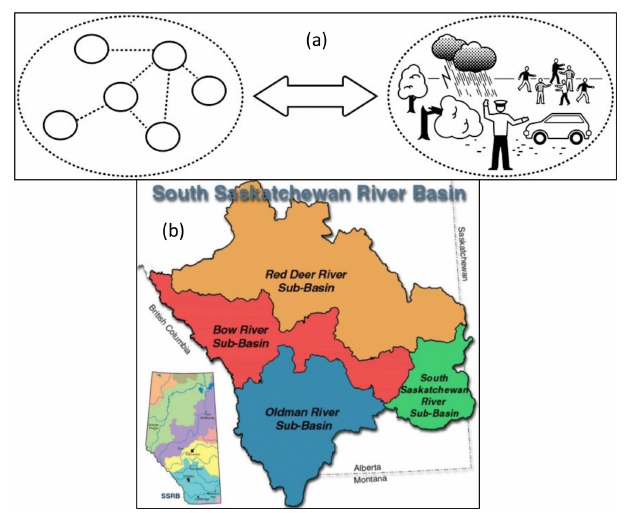
Figure 4. (a) Demarcation of a system using control volumes and lines (Hieronymi, 2013). (b) Sub-basins used as an in-class example (Sauchyn et al.,